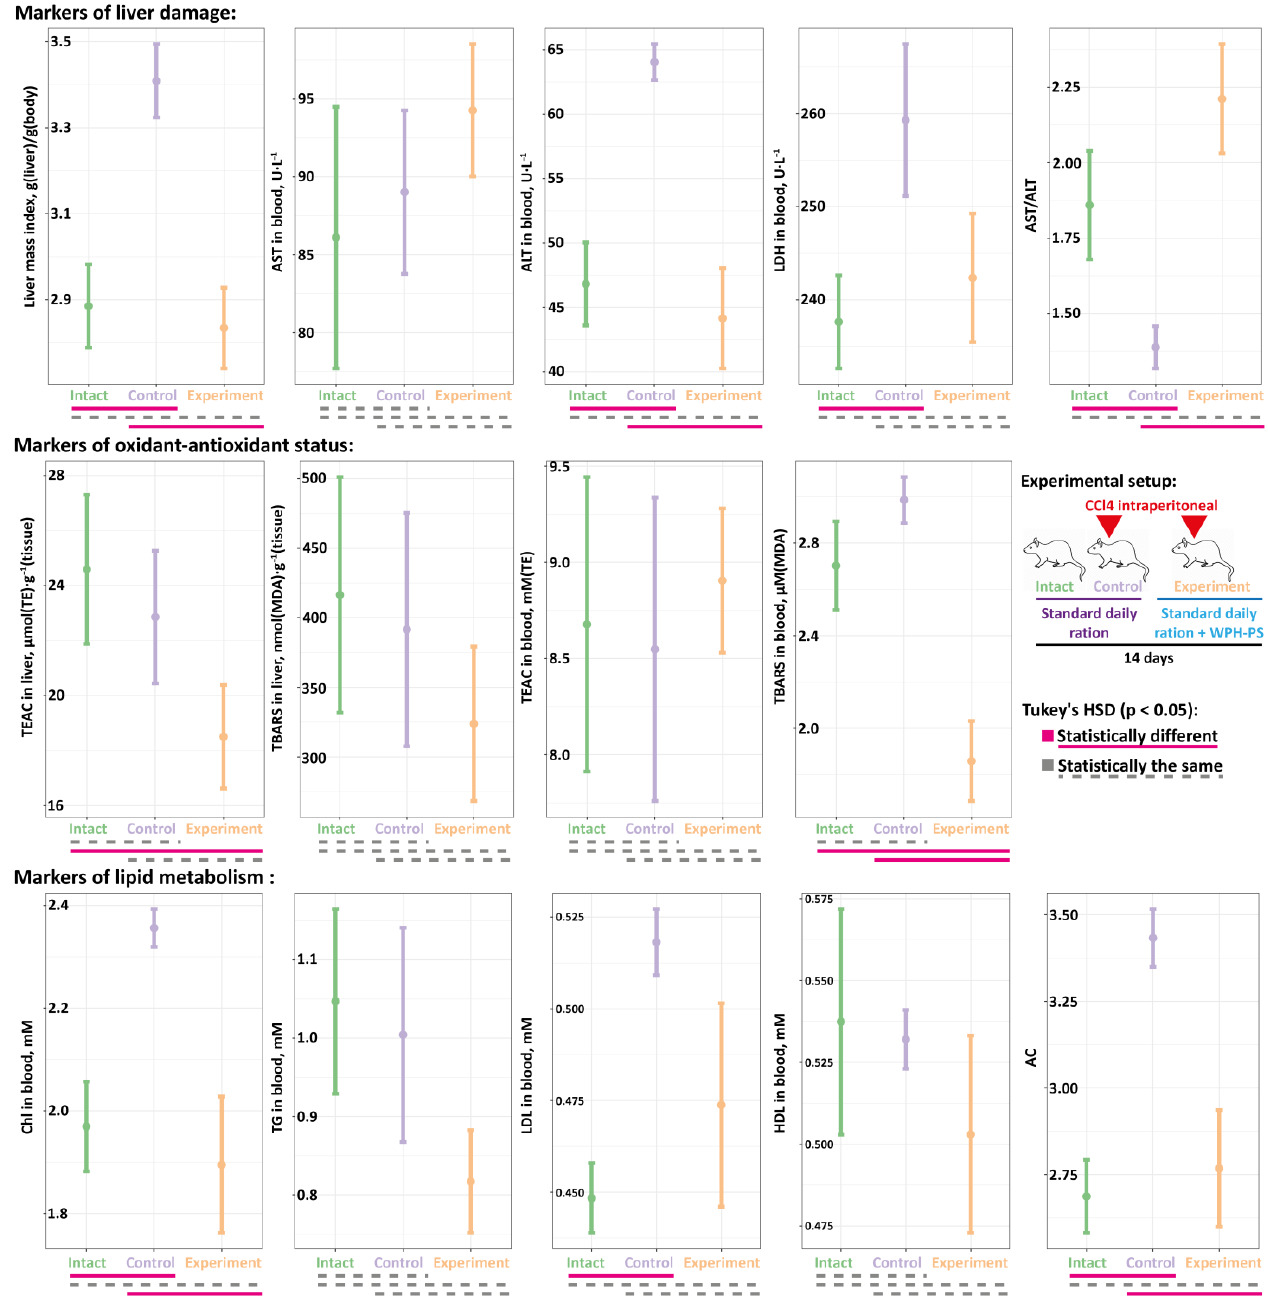
Figure 5. The in vivo assessment of hepatoprotective properties for WPH–PS composition using Wistar rats with CCl 4 -induced hepatic injury animal model. Each group of Wistars (intact, control and experimental) contained 10 ani- mals.